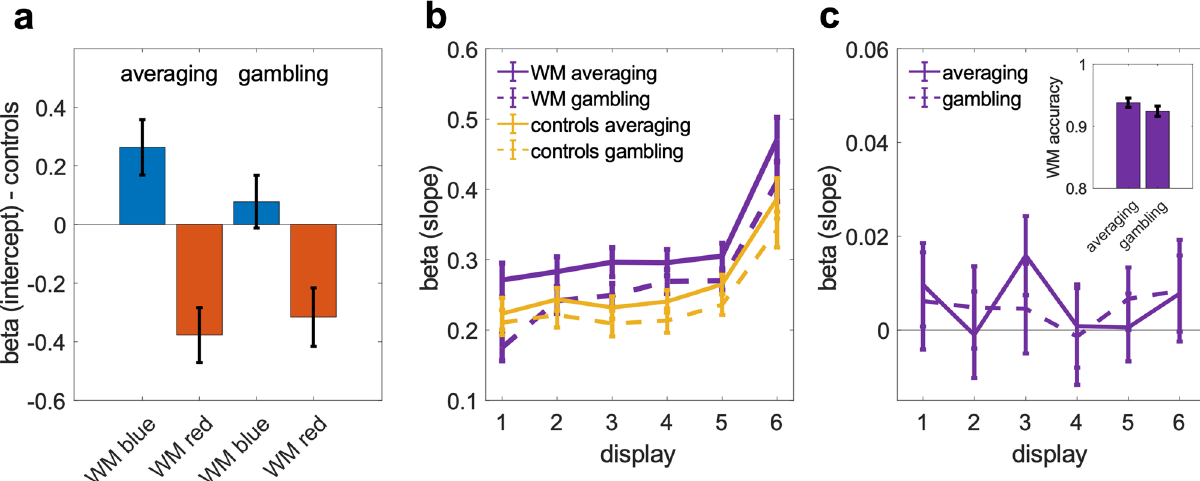
Figure 5. Averaging or gambling—color information. ( a ) WM-induced choice bias relative to pooled control conditions (cf. Fig. 4b) plotted separately for “averaging” (left bars, n = 35) and “gambling” variants (right bars, n = 33) of the decision task. ( b ) choice sensitivity (slopes) for each of the six displays in the decision stream (cf. Fig. 4c), plotted separately for the averaging and gambling tasks. Yellow curves show pooled control conditions. ( c ) WM recall bias (cf. inset in Fig. 4d) plotted separately for the averaging and gambling conditions. Small inset plot shows proportion correct color recall. Error bars in all panels show standard error of the